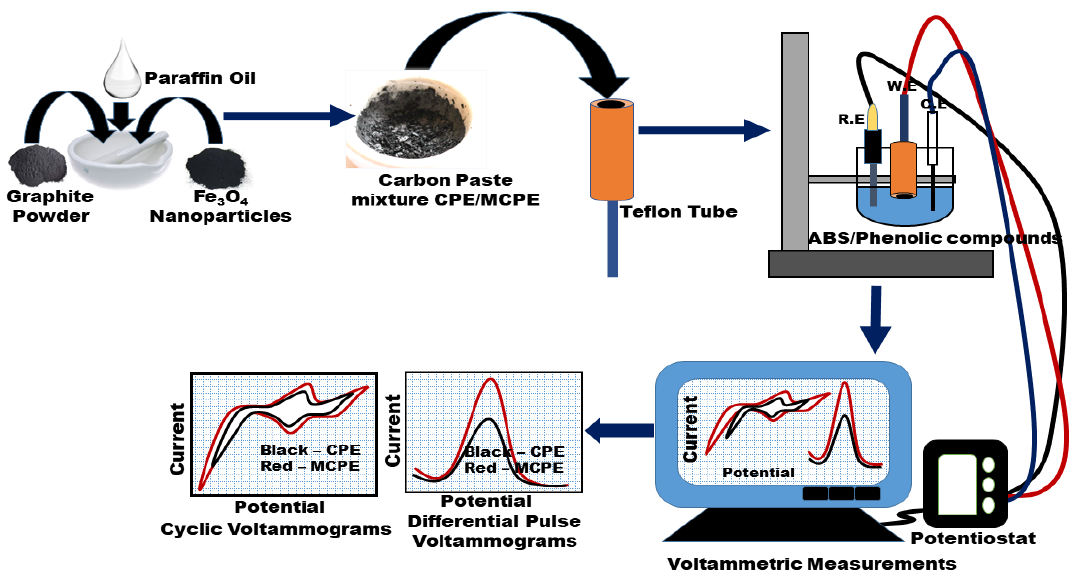
Figure 2. Schematic diagram of the phenolic compounds electrochemical sensor preparation.